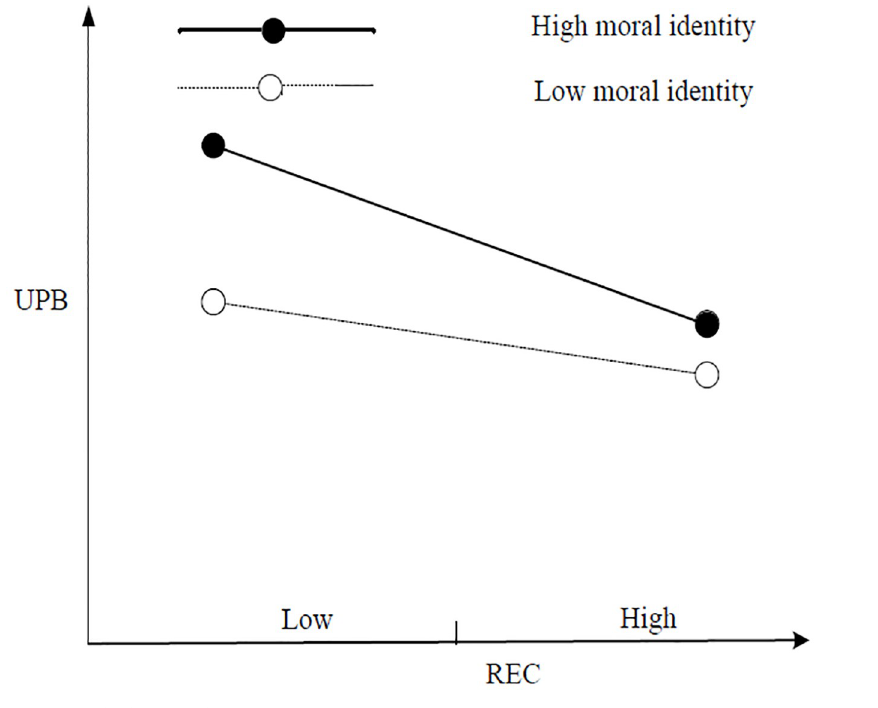
Fig 4. Simple slope test for